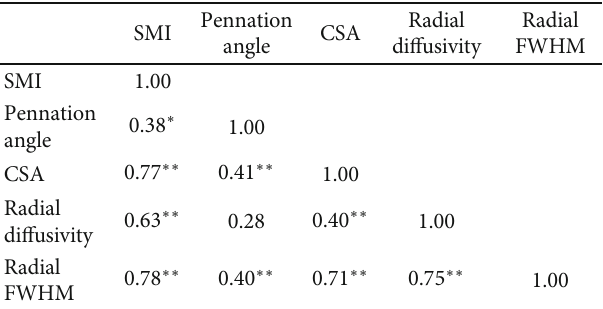
Table 3: Summary of the correlation between muscle parameters and magnetic resonance imaging parameters of the tibialis anterior muscle. Pennation Radial SMI CSA angle